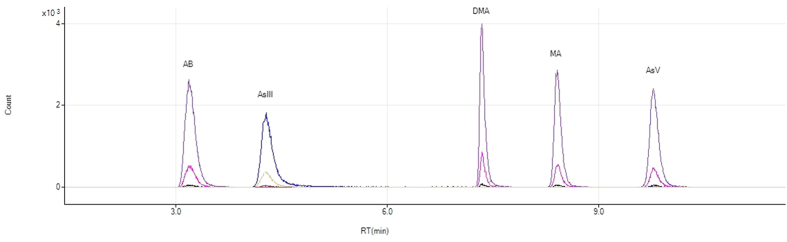
Arsenic speciation standard chromatogram.Chromatograms obtained for standard calibration solutions at 1, 10 and 50 μg/ L. Calibration of arsenate (AsV), methylarsonate (MA), dimethylarsinate (DMA) and arsenobetaine (AB) was performed with mixed solutions of arsenic (V) oxide hydrate (As2O5·xH2O), monomethylarsonic acid ((CH3AsO(OH)2), dimethylarsinic acid ((CH3)2AsO(OH)) and arsenobetaine ((CH3)3As + CH2COO-) respectively. Calibration of arsenite (AsIII) has been plotted simultaneously and was achieved with separate solutions of arsenic trioxide (As2O3).